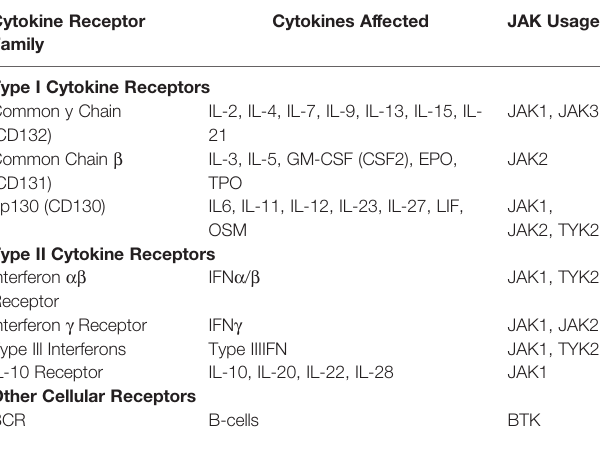
TABLE 2 | JAK usage among the common cytokine receptor families. Cytokine Receptor